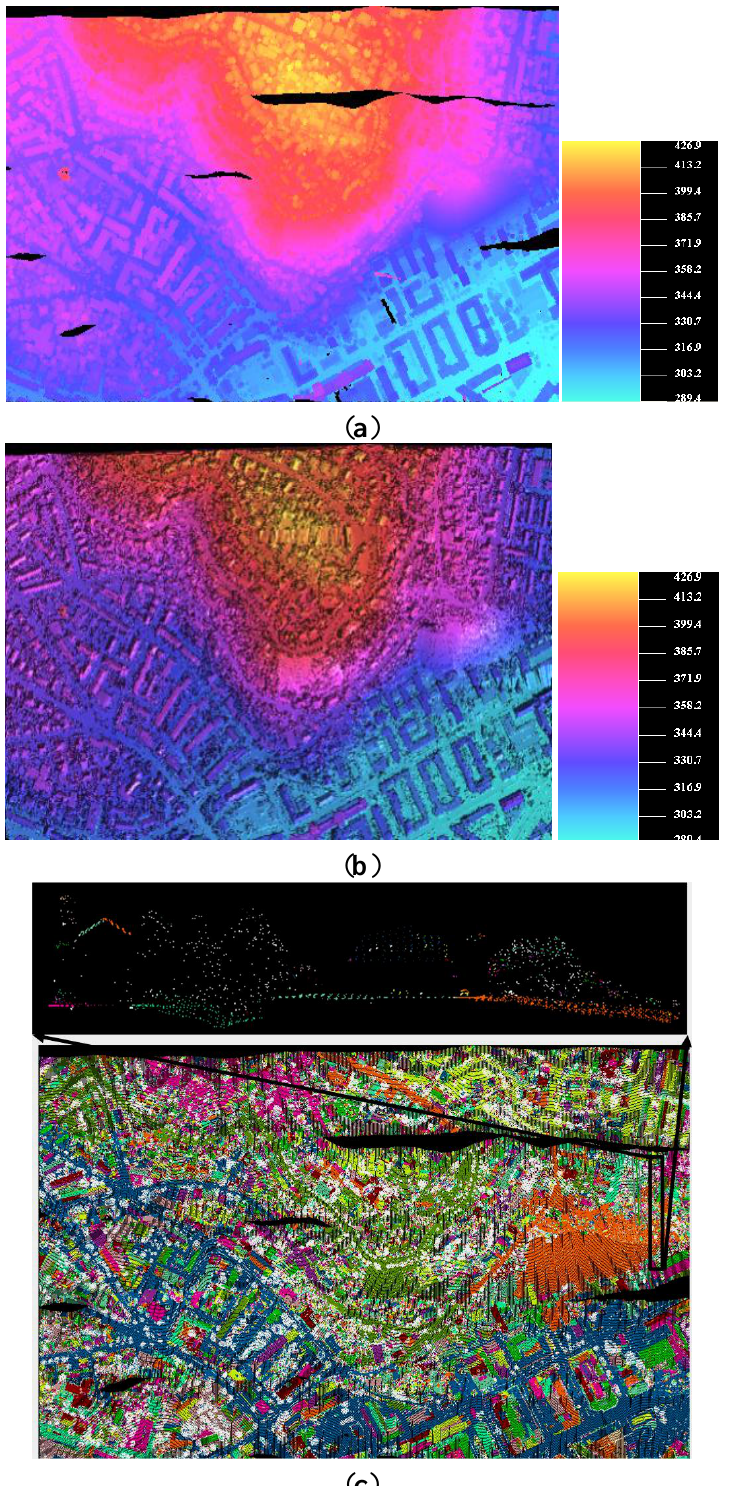
Figure 5. Filtering and results of testing data about CSite1: ( a ) The remaining point cloud after outlier removal; ( b ) TIN of the data in (a); ( c ) Segmentation result of PCSS; ( d ) Detected vegetation measurements by multiple echoes analysis of segments; ( e ) Detected ground seed segments colored by the labeling number; ( f ) Detected ground measurements by SBF method; ( g ) Detected ground measurements by the classic PTD method; ( h ) Differences between (f) and